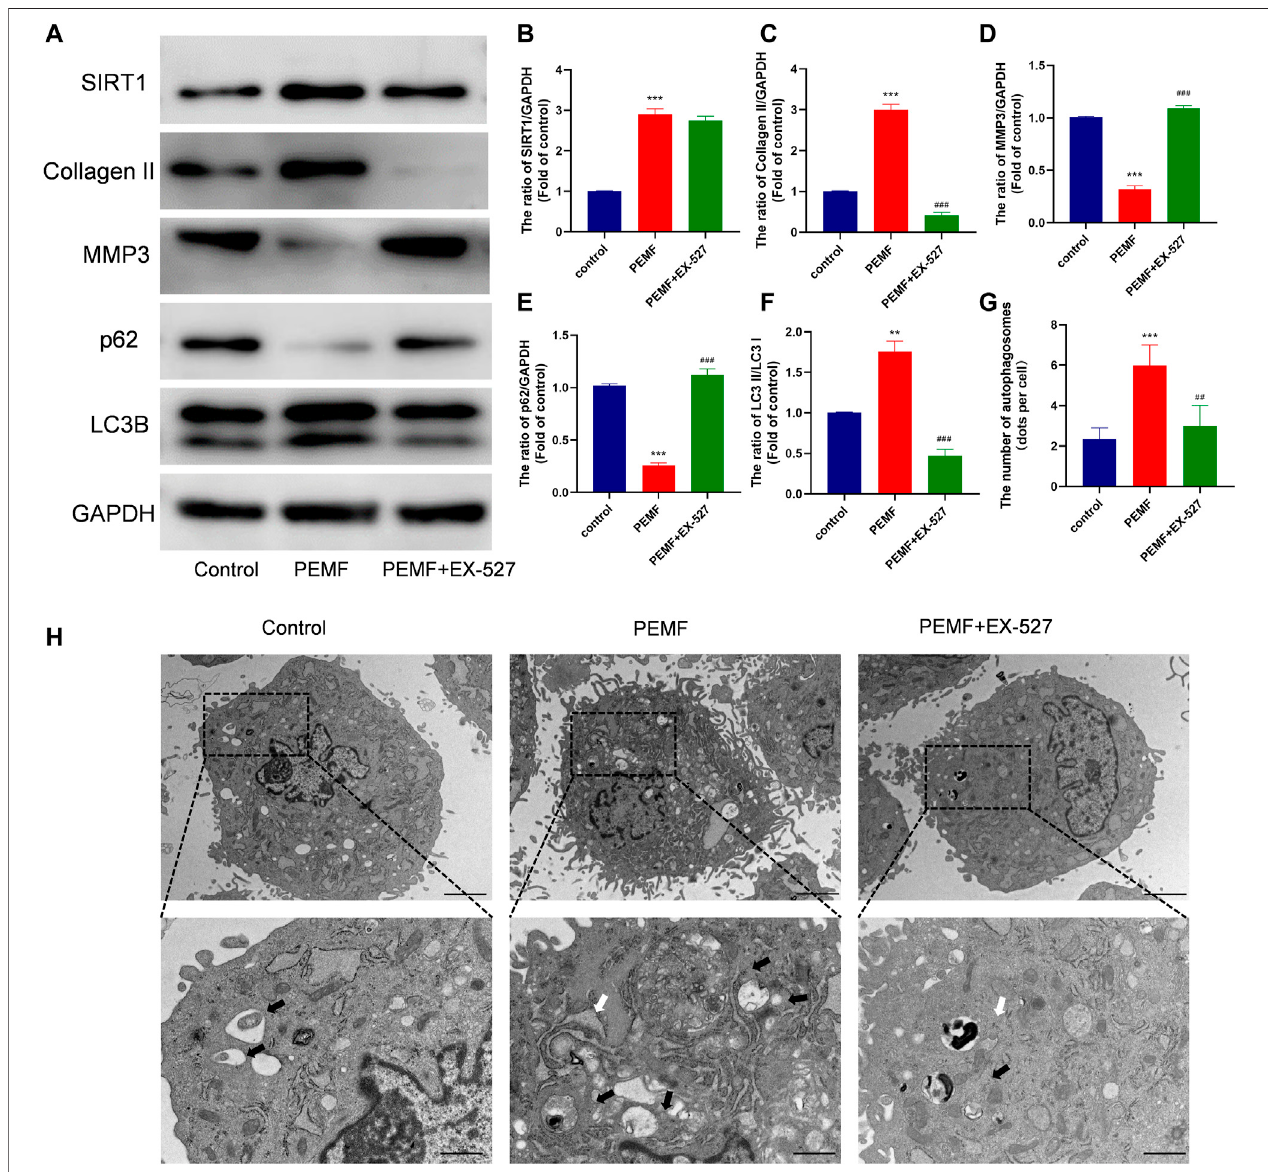
FIGURE 5 | PEMF regulates ECM related makers expression via SIRT1-stimulated autophagic activation (A – F) Western blot and semi-quantitative analyses of SIRT1, Collagen II, MMP-3, p62 and LC3B protein levels (n = 3). (G – H) Autophagosomes and autophagolysosomes, as visualized by transmission electron microscopy (Blackarrow, autophagosome; White arrow, autophagolysosome, scalebar:2 μ m, 0.5 μ m).** p < 0.01vs. control, *** p < 0.001 vs.control,## p < 0.01vs. PEMF, ### p < 0.001 vs. PEMF. Data expressed as means ± SD.